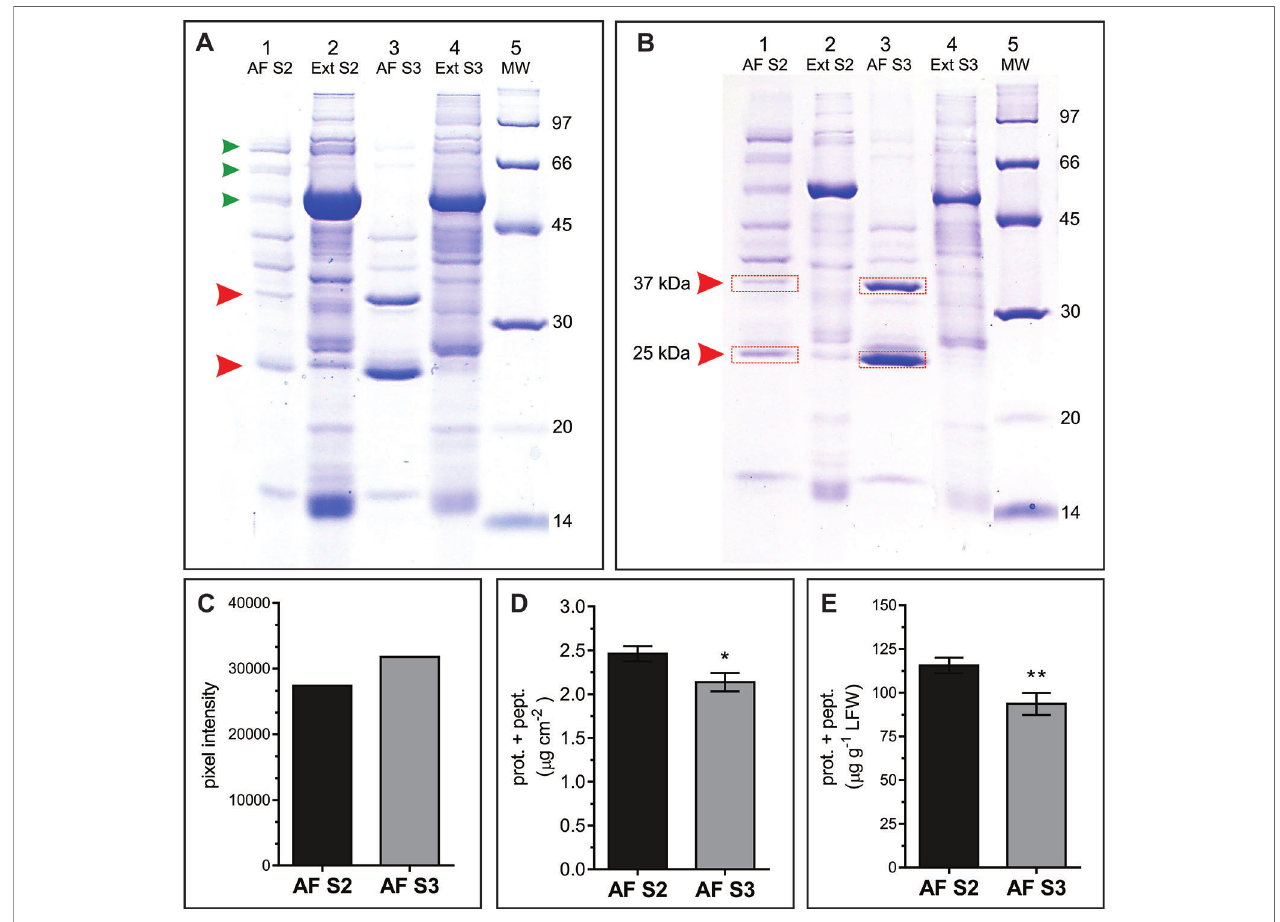
FIGURE 5 | Protein pro fi le of AF S2 and AF S3. (A , B) Representative SDS-PAGE of total soluble leaf proteins (Ext) and apoplastic fl uid (AF). (A) Lanes 1 and 3, proteins from 8.64 cm 2 of leaf; lanes 2 and 4, proteins from 0.196 cm 2 of leaf. Arrowheads mark bands in AF that differ between S2 and S3. (B) Each lane contains ~20 m g of protein. MW: molecular weight markers (masses in kDa). Red rectangles show the bands excised and analyzed by mass spectrometry. (C) Densitometric quanti fi cation of lanes 1 and 3 from gel A. (D , E) Total protein and peptide content in AF S2 and AF S3, expressed as µg of proteins and peptides per unit of leaf area (D) and as µg of proteins and peptides per gram of leaf fresh weight (LFW), respectively. Mean values ± SEM of biological samples, n. S2 n = 28, S3 n = 30. For each biological sample two technical replicates were taken. Signi fi cant differences were calculated at P ≤ 0.05 between leaf stages using the Student's t-test: *, P < 0.05; ** , P <